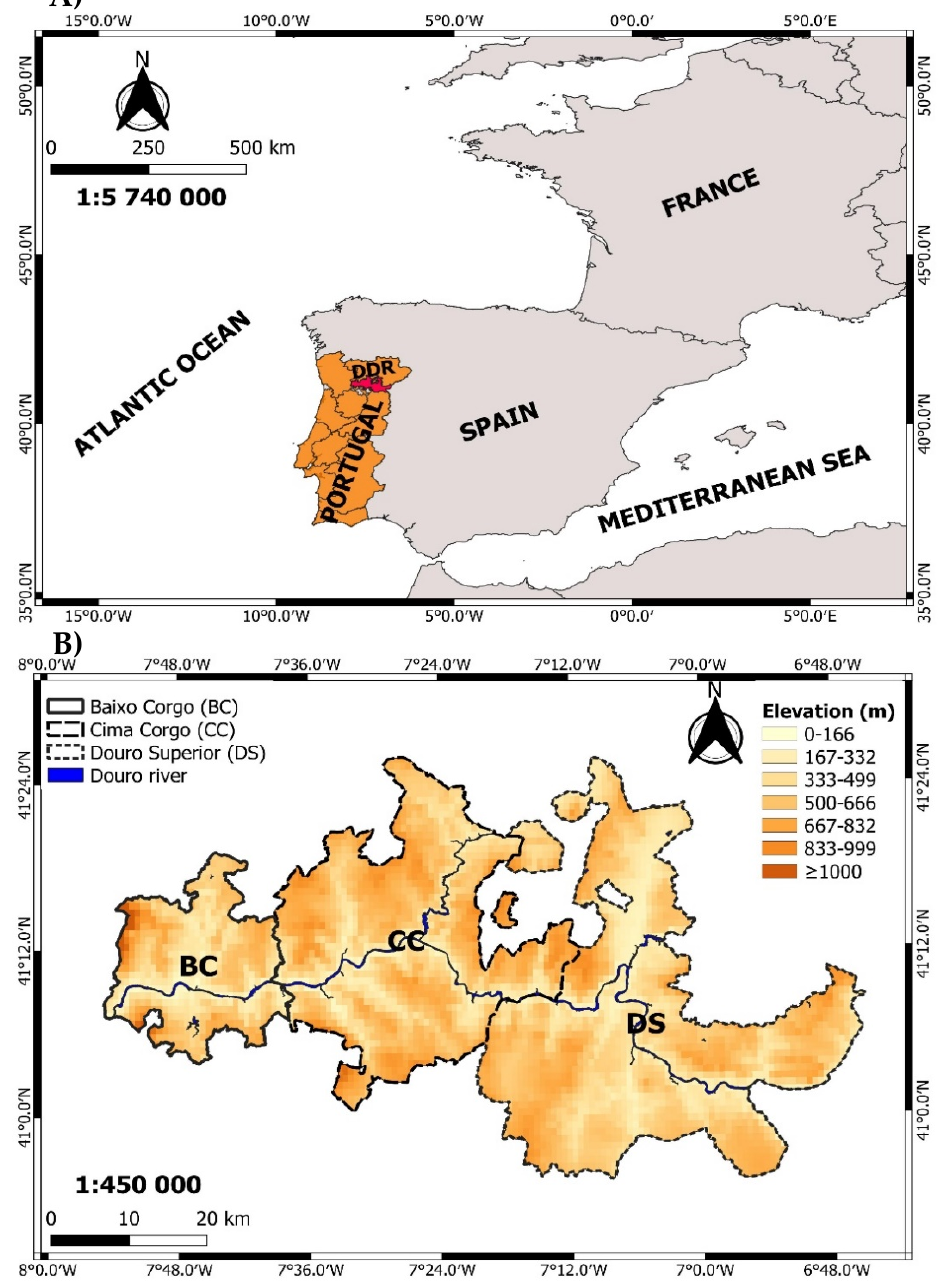
Figure 1. ( A ) Map with the geographical location of Portugal (orange), as well as the Douro Demarcated Region (red). ( B ) Douro Demarcated Region map with its three sub-regions: Baixo Corgo (BC, left side, continuous line), Cima Corgo (CC, middle, long line) and Douro Superior (DS, right side, broken line). The Douro River and other main watercourses are also represented. Elevation at an ~1 km grid resolution is also displayed.